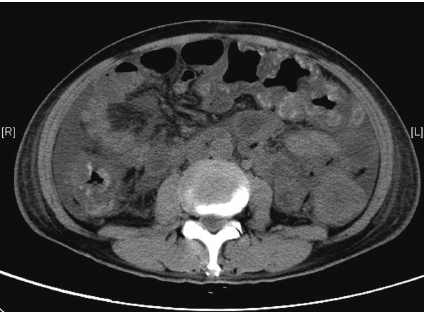
Figure 1: Abdominal computer tomography shows diffuse irregular mural thickening of the large bowel loops with scattered mucosal and submucosal hyperdensity suggestive of hemorrhage.